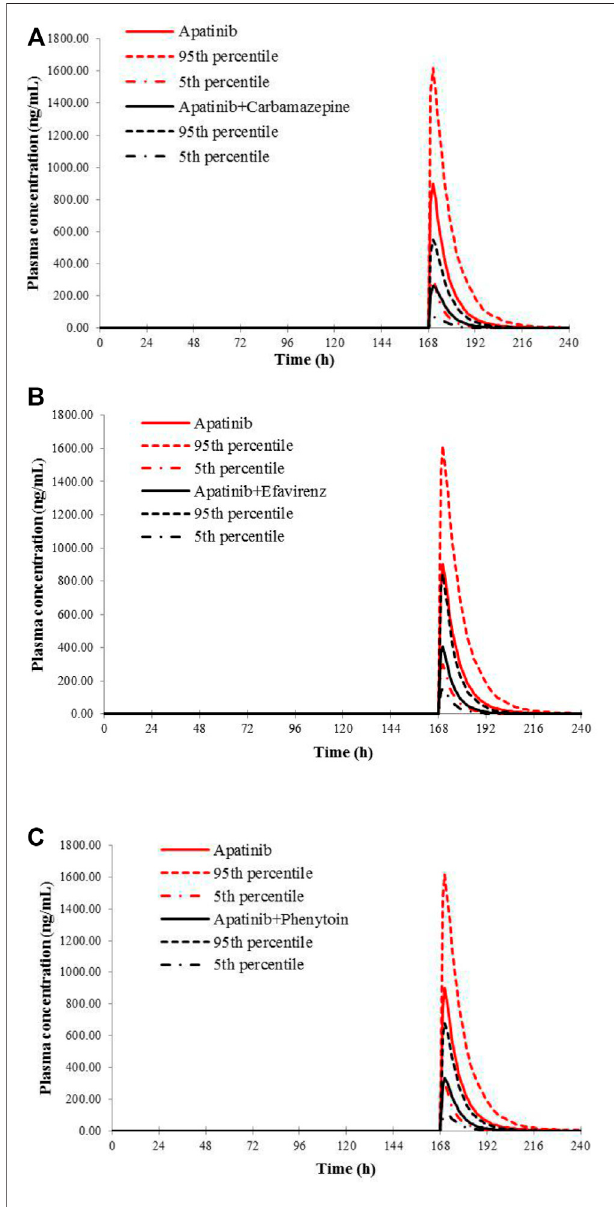
FIGURE 5 | Predicted mean plasma concentration – time curves of apatinib with or without co-administration of CYP 3A4 inducers, carbamazepine (A) , efavirenz (B) , and phenytoin (C) .